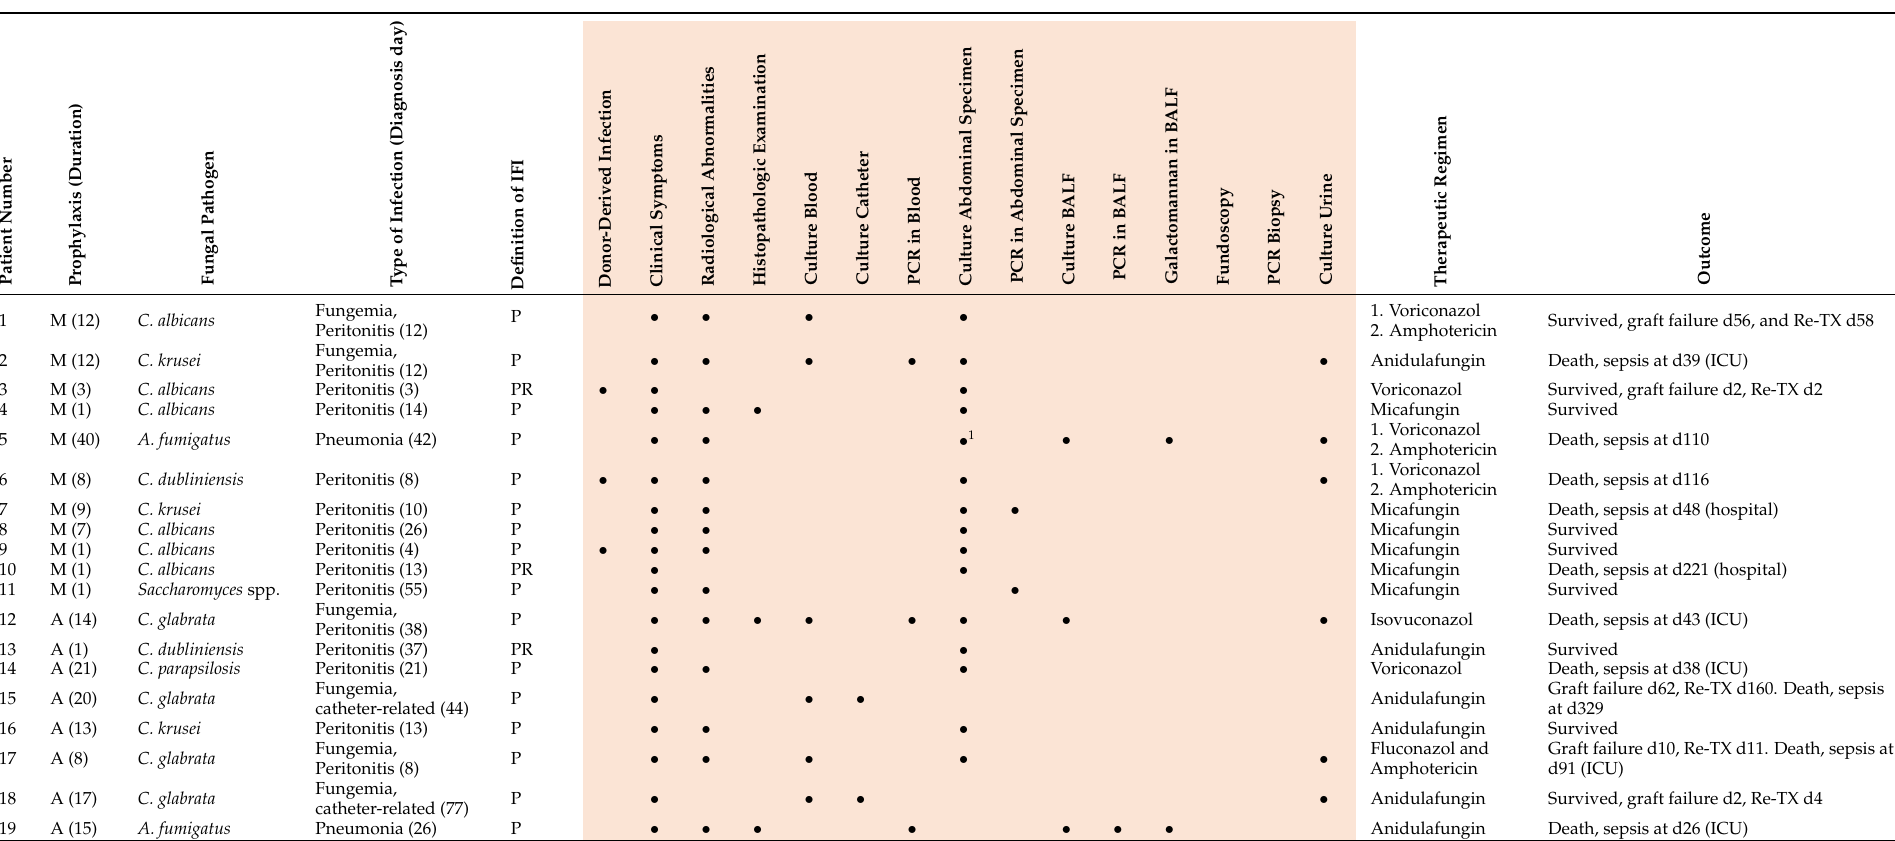
Table 4. Overview of the diagnosed IFI ( n =